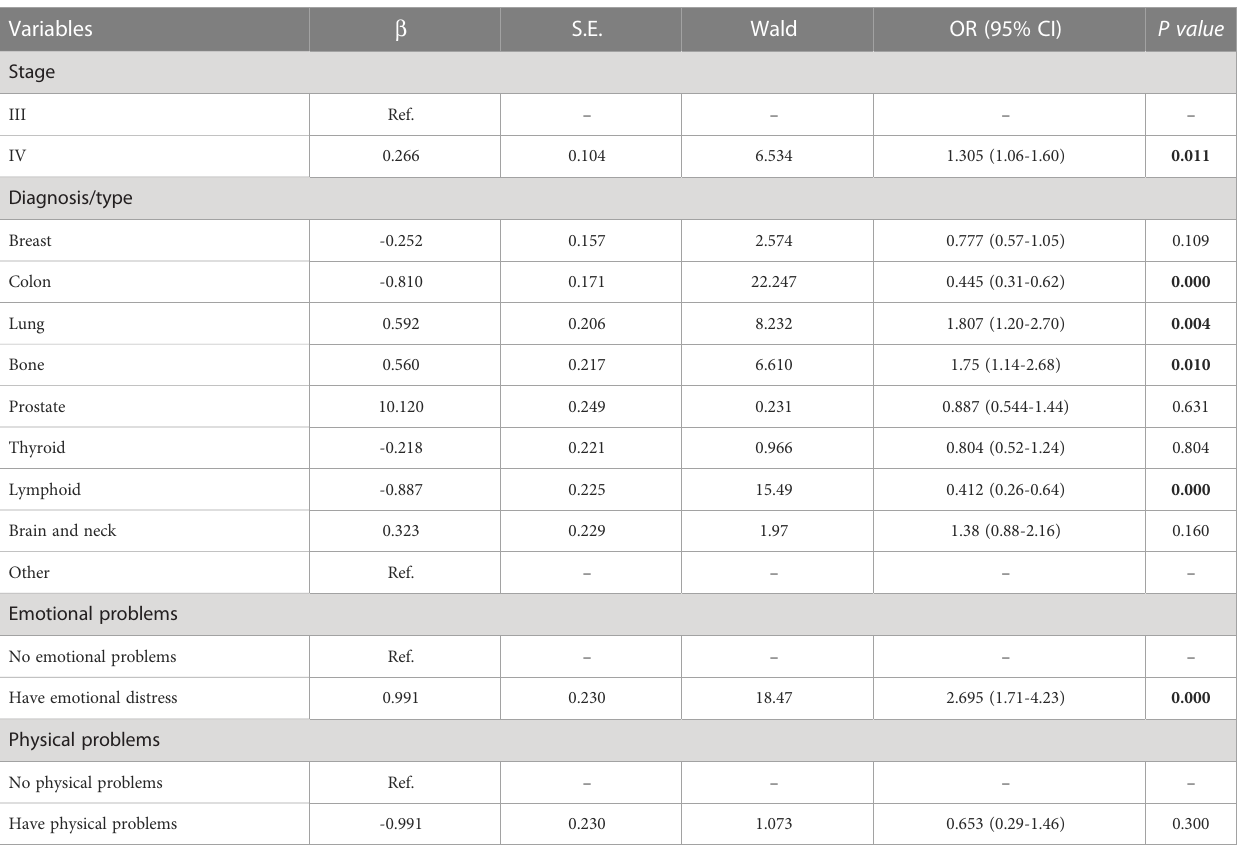
TABLE 5 Multivariate logistic regression model